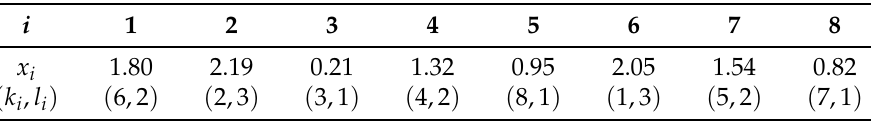
Table 2. Illustration of the solution decoding